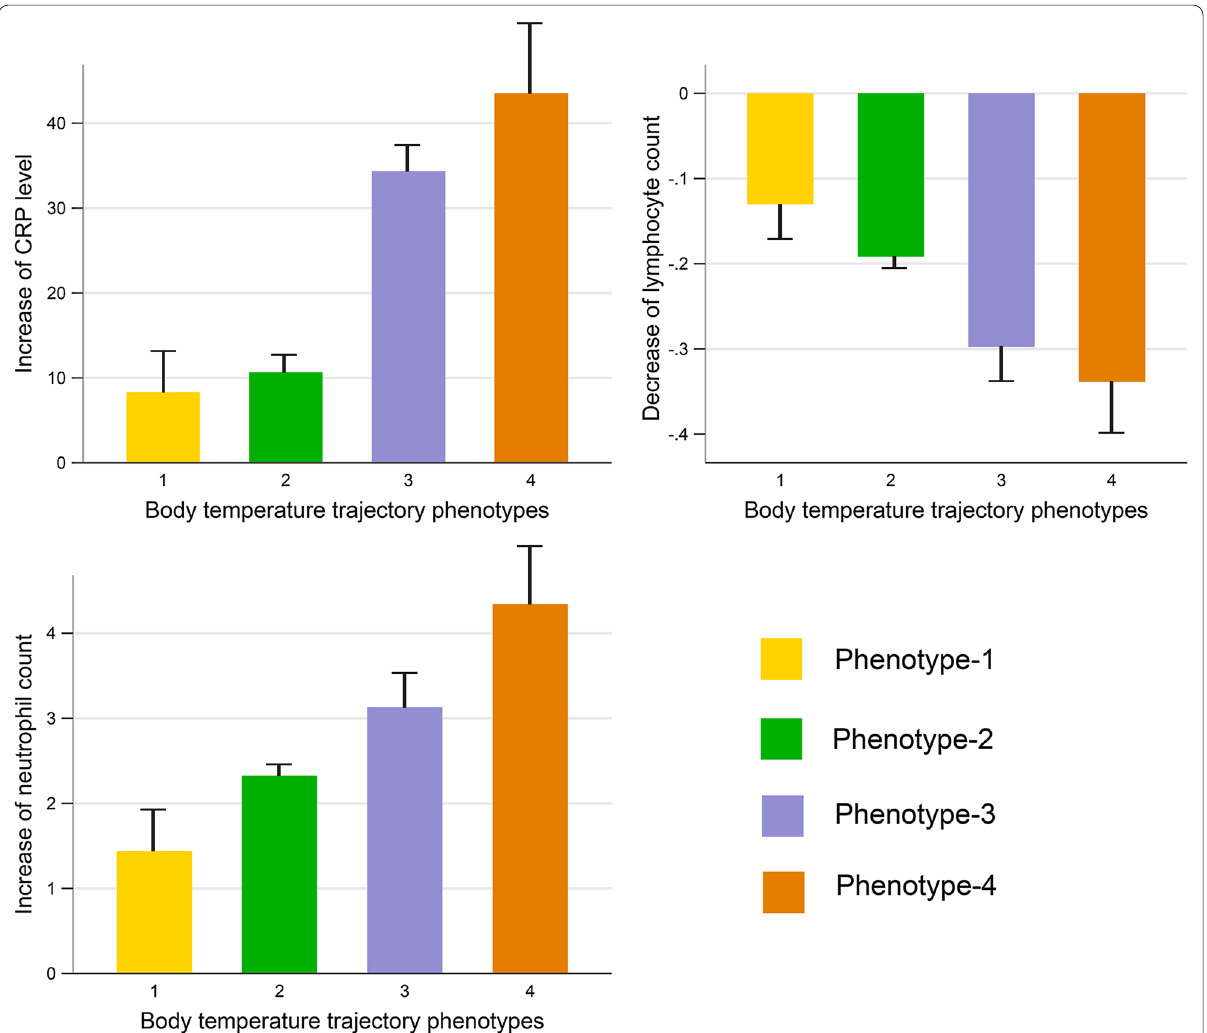
Fig. 2 Comparisons of inflammatory marker levels according to the temperature-trajectory phenotype. Compared with those in Phenotypes 1 and 2 (normothermic or fever with rapid defervescence), the change in the CRP level is significantly higher ( p < 0.001) and the change in the lymphocyte count is significantly lower ( p < 0.001) in Phenotypes 3 and 4. The maximum SOFA score showed a stepwise increase from Phenotype 1–4 ( p < 0.001). The vertical line above each bar represents the standard error of mean. CRP C-reactive protein, SOFA Sequential Organ Failure